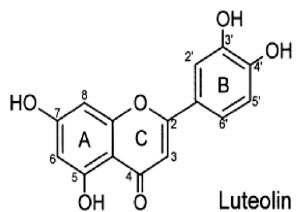
Figure 1. Chemical structure of luteolin (3 ′ ,4 ′